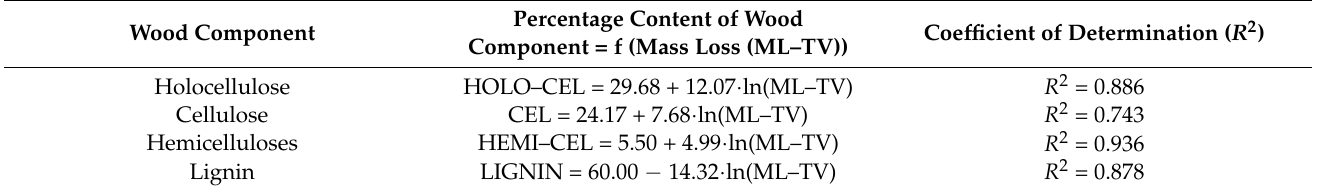
Figure 7. The percent content of wood components of the thermally–fungally attacked spruce wood according to the mass loss caused by T. versicolor (Correlation equations are listed in Table 3). Table 3. Correlations between the percent content of wood components and the mass loss of the Norway spruce wood samples during fungal attack by T. versicolor.